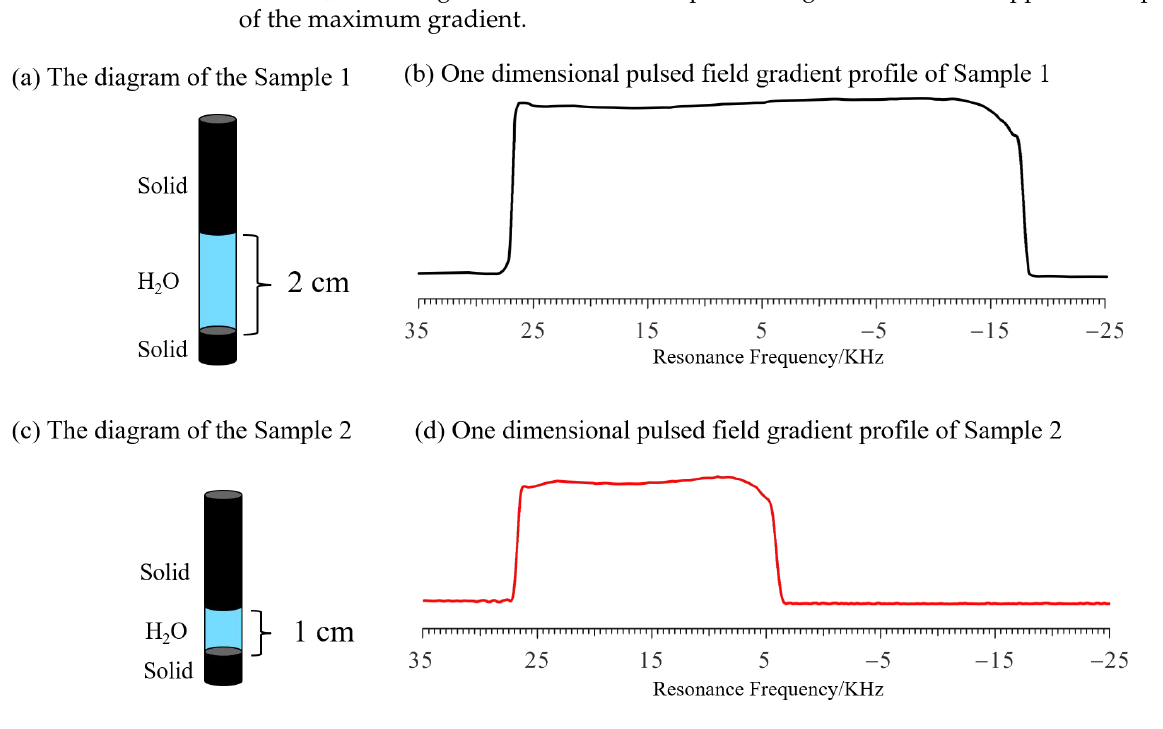
Figure 2. One − dimensional, pulsed − field gradient, nuclear magnetic resonance (1D NMR) profiles of deionized water in Shigemi tubes obtained by changing the sample height (Samples 1 and 2) while maintaining the same strength of the gradient pulses. ( a ) The diagram (Blue represents water and black represents a glass solid) of Sample 1 (220 µ L deionized water; 2 cm height). ( b ) The gradient profile of sample 1 (10% maximum gradient strength G max ). ( c ) The diagram ( Blue represents water and black represents a glass solid) of Sample 2 (110 μL deionized water; 1 cm height). ( d ) The gradient profile of sample 2 (10% maximum gradient strength). All profiles were obtained with 1 scan.